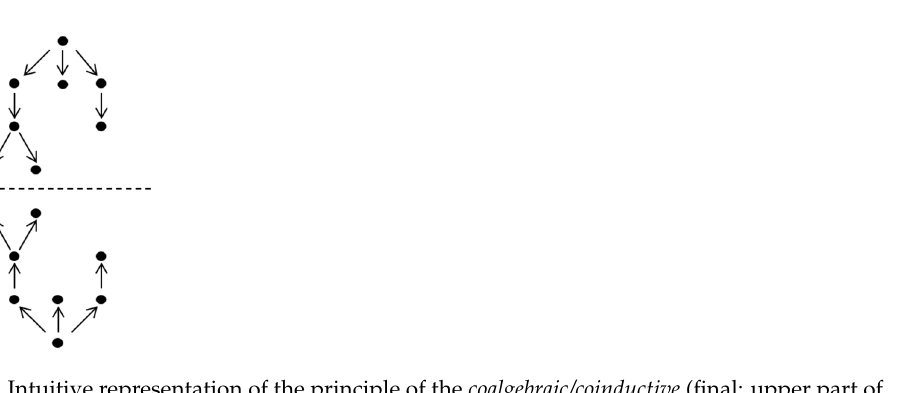
Figure 10. Intuitive representation of the principle of the coalgebraic/coinductive (final: upper part of figure) algebraic/inductive (initial: lower part of figure) concurrent computations, where the coalgebra functorially mirrors its structure over the algebra, and for which, in both directions, “the finitary is the limit of the successions of finites” (Abramsky).